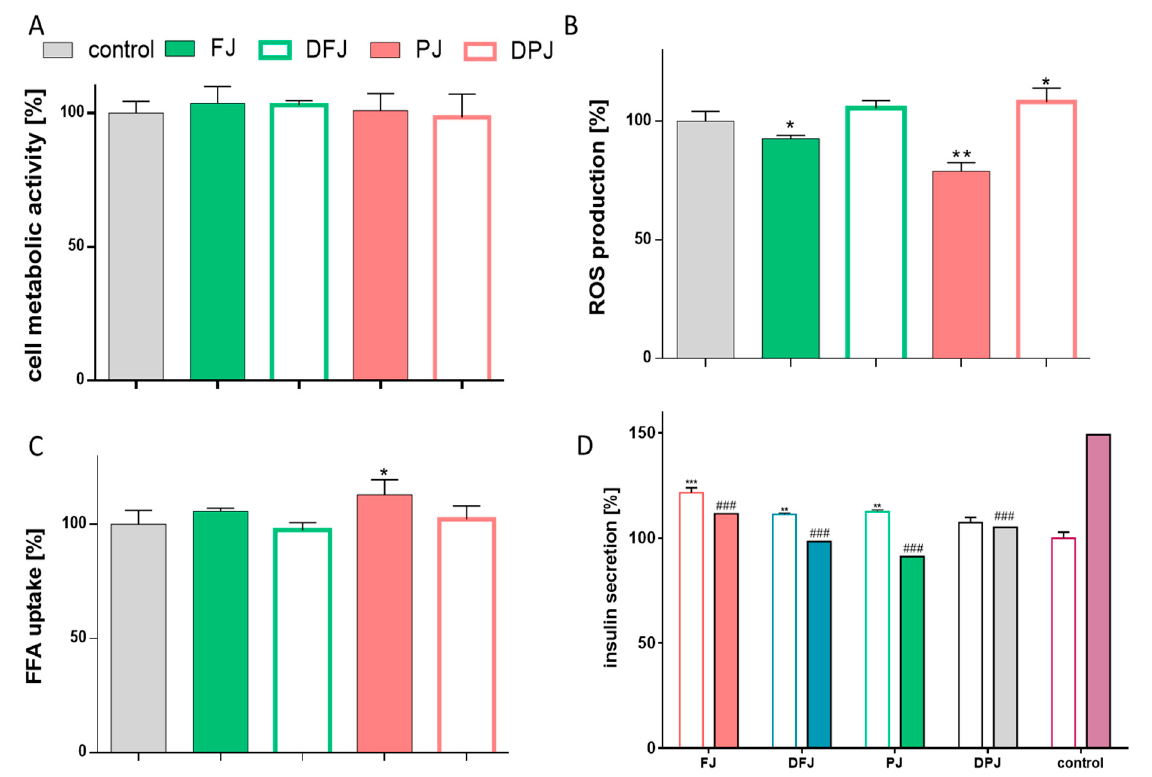
Figure 6. The influence of V. opulus samples on MIN6 cells’ metabolic activity after 24 h exposure of fresh juice (FJ), digested fresh juice (DFJ), purified juice (PJ), and digested purified juice (DPJ) at non-cytotoxic concentration (IC 0 ) ( A ); intracellular ROS generation ( B ); fatty acid analogue TF2-C12 uptake ( C ); insulin secretion by cells in low (open bars) or high (closed bars) glucose conditions ( D ). Control cells were not exposed to any compound except vehicle; values are means ± standard deviations from at least three independent experiments, n ≥ 9; statistical significance was calculated versus control cells (untreated), for low glucose (*) or high glucose (#); * p ≤ 0.05, ** p ≤ 0.01, *** p ≤ 0.001; ; # p ≤ 0.05, ## p ≤ 0.01, ### p ≤ 0.001.